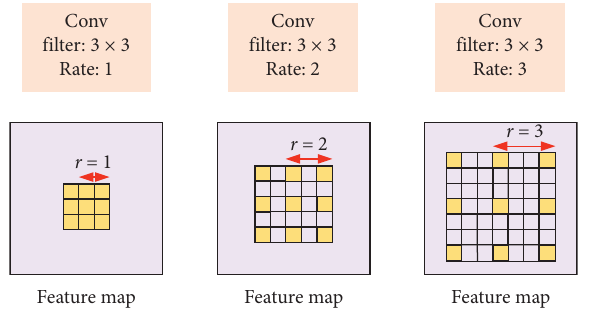
Figure 5: Atrous convolution with filter size 3 × 3 and different rates. A-branch: atrous convolution with filter size 3 × 3 and rate ( r ) � 1. B-branch: atrous convolution with filter size 3 × 3 and rate ( r ) � 2. C-branch: atrous convolution with filter size 3 × 3 and rate ( r ) �